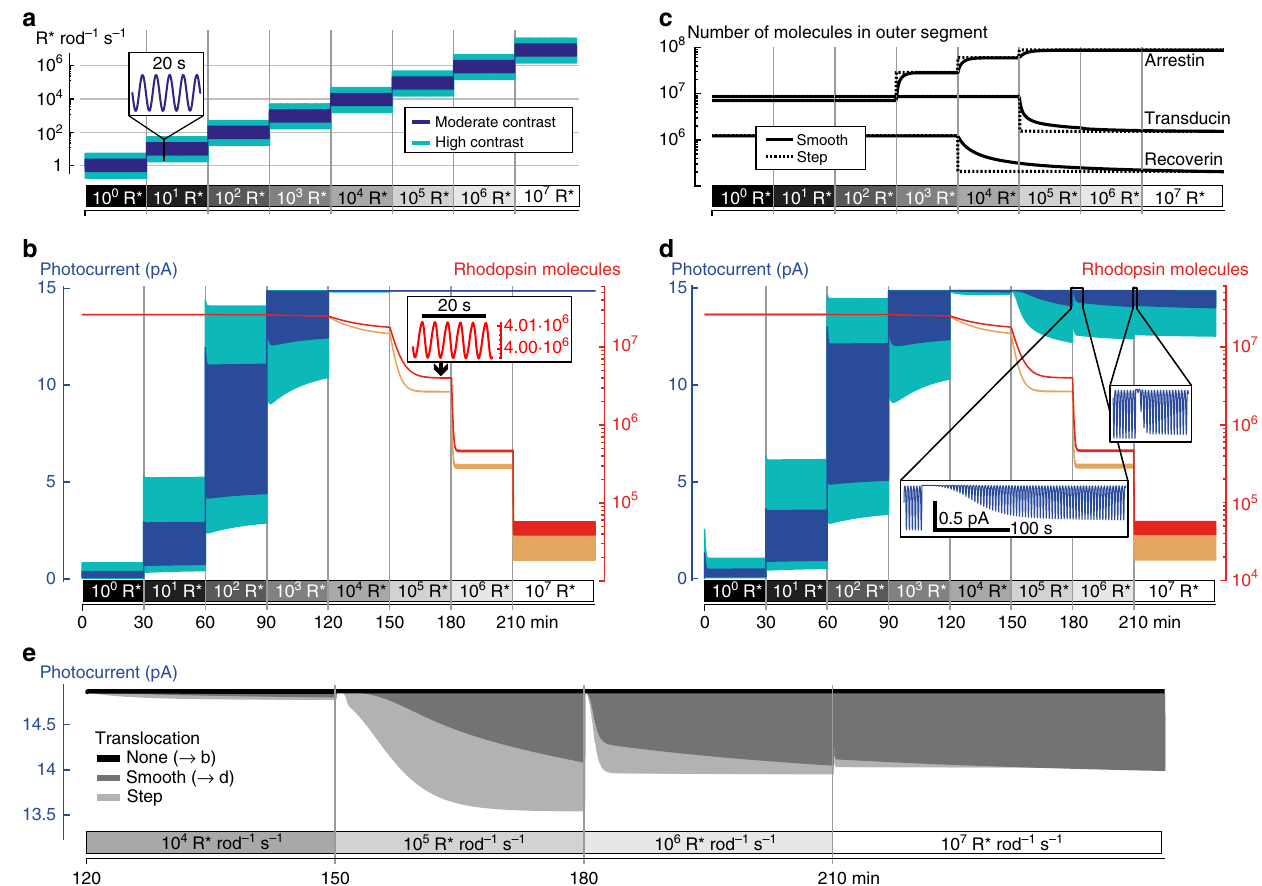
Fig. 7 Computational model of rod light responses. a Stimulus used for modeling was a sinusoid (0.25 Hz) of either moderate (blue) or high (cyan) amplitude (full amplitude 0.75 or 1.5 log units; Michelson contrast 0.7 or 0.94). Every 30 min, the ambient level increased by 1 log unit, ranging from 1 R* rod − 1 s − 1 to 10 7 R* rod − 1 s − 1 . b Behavior of the original model by Invergo et al. with few adjustments (Methods). Left y -axis: elicited photocurrents to moderate (blue) or high (cyan) contrast stimulus; right y -axis, logarithmic: number of unbleached rhodopsin molecules in outer segment to moderate (red) or high (orange) contrast stimulus. Inset: Detailed view of number of rhodopsin molecules. c Implementation of arrestin, transducing, and recoverin translocation as smooth kinetic processes (solid lines) or as step-like events (dashed lines). d Model behavior as in b , with translocation of arrestin, transducing, and recoverin modeled as smooth kinetic processes. Both insets are plotted on the same scale. e Photocurrents at photopic light levels to the moderate contrast stimulus with different implementation of transducin, arrestin, and recoverin translocation. Black: no translocation (replicated blue curve from b ). Dark gray: smooth translocation (replicated blue curve from d ). Light gray: step-like